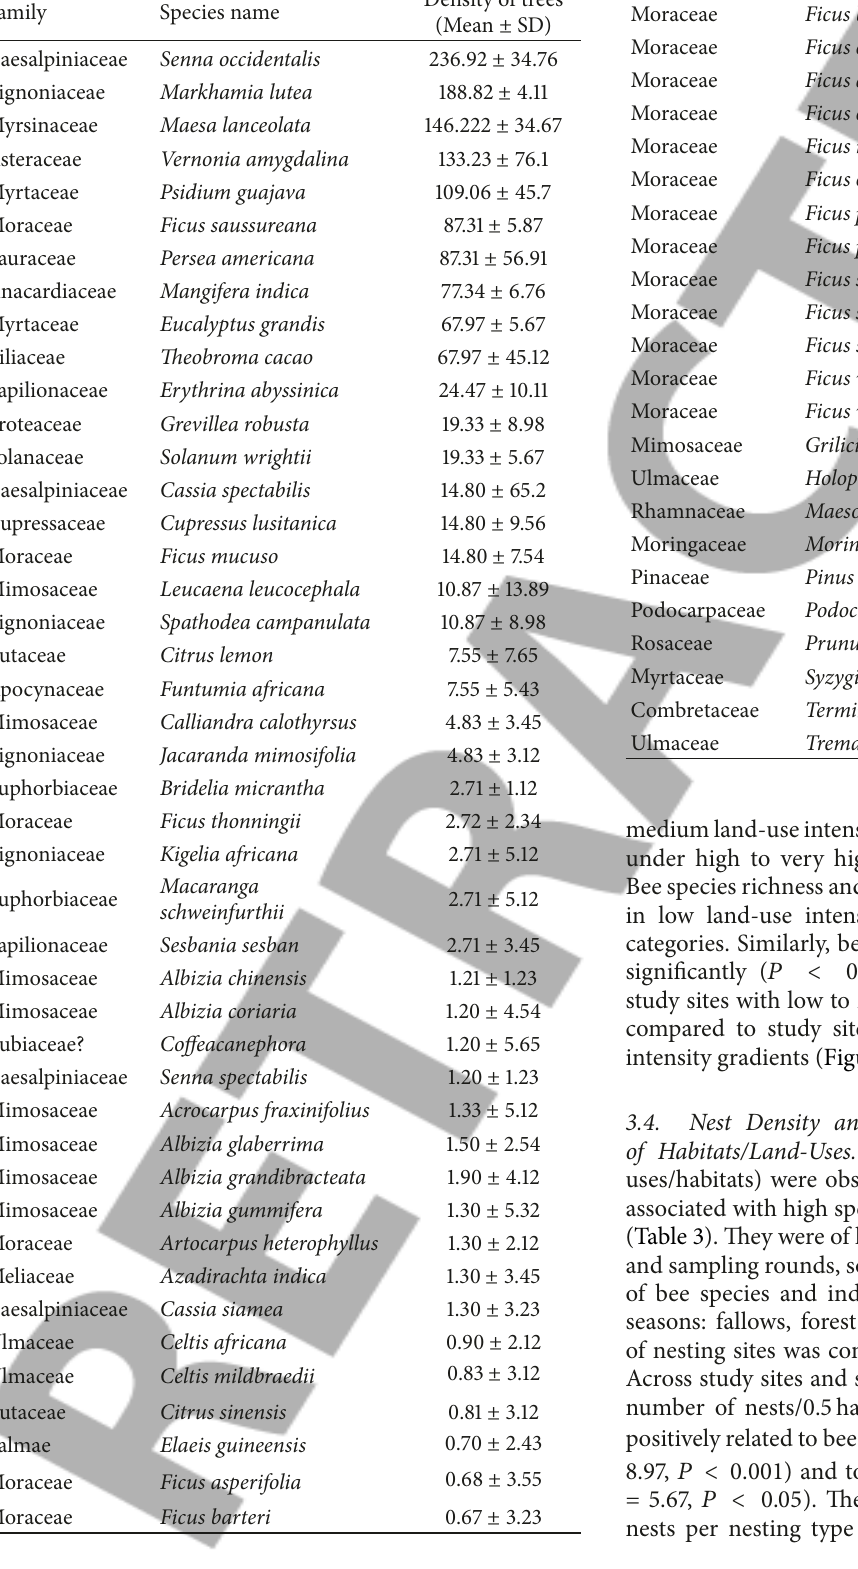
Table 5: Density(numberoftrees/5ha) ofnesttreespecies recorded in farmlands of central Uganda during bee faunistic surveys con- ducted in 2006. Data are means of 26 study sites and five sampling rounds conducted in 2006